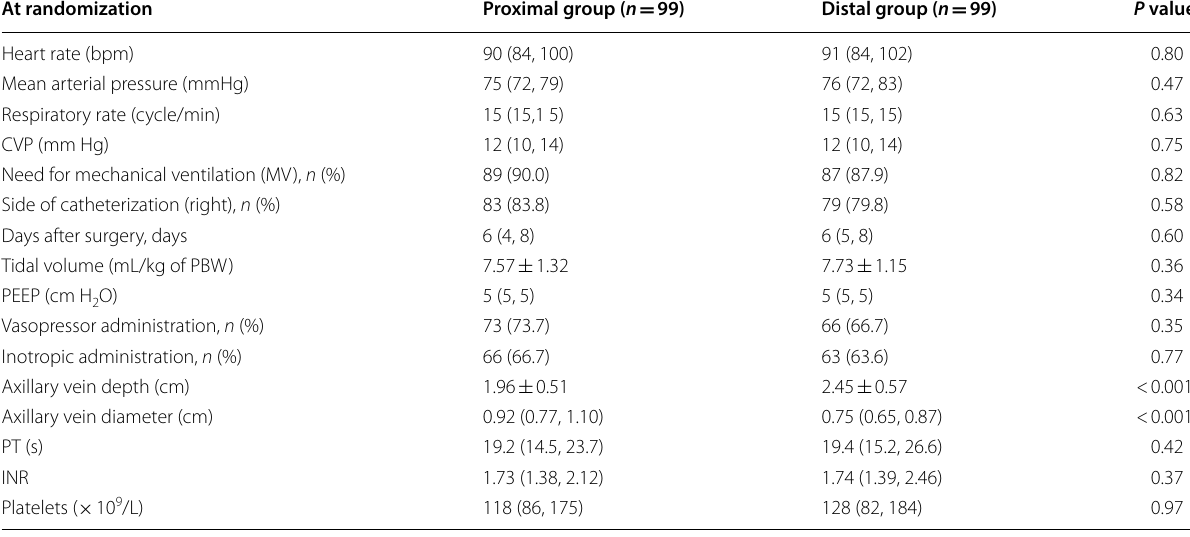
Continuous data are presented as the mean (SD) or median (IQR). Categorical data are presented as counts (%)